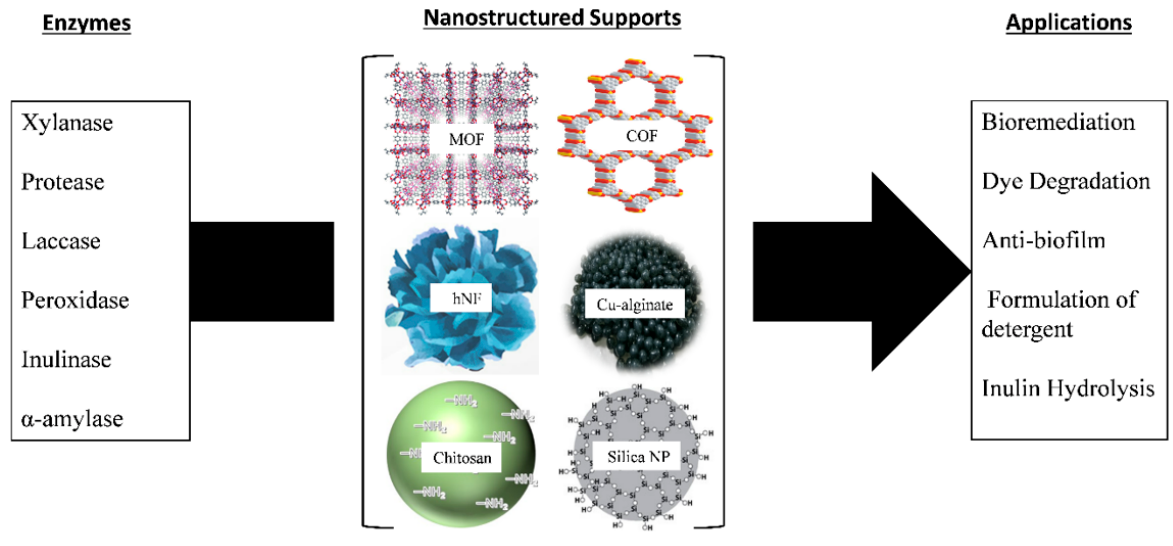
Figure 3. Examples of enzyme immobilization on various solid supports and their applications [95].